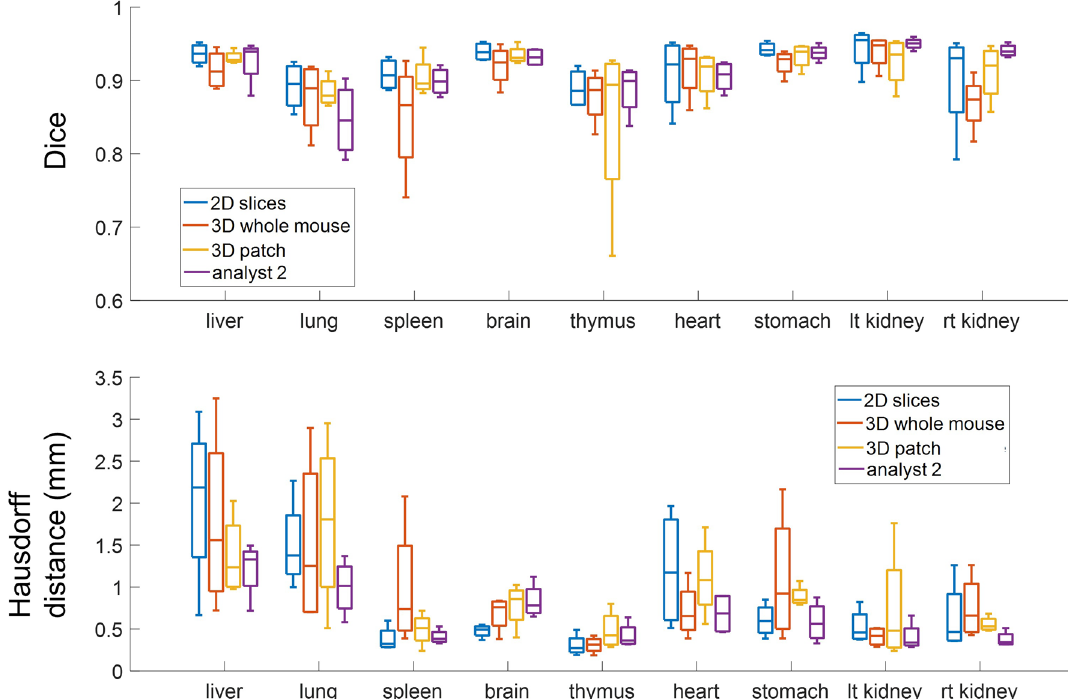
Figure 5. Performance of the three networks, and Analyst 2, against the manual segmentation of Analyst 1. (Top) Dice scores for the three proposed methods against the annotations of Analyst 1 (the ground truth), for considered organs, along with Dice scores for Analyst 2, as compared to Analyst 1. (Bottom) Similar plots for Hausdorff distance. The median Dice scores and Hausdorff distances for the best method, 2D-slices , were similar to those for Analyst 2, compared against Analyst 1. Refer to the text for a statistical